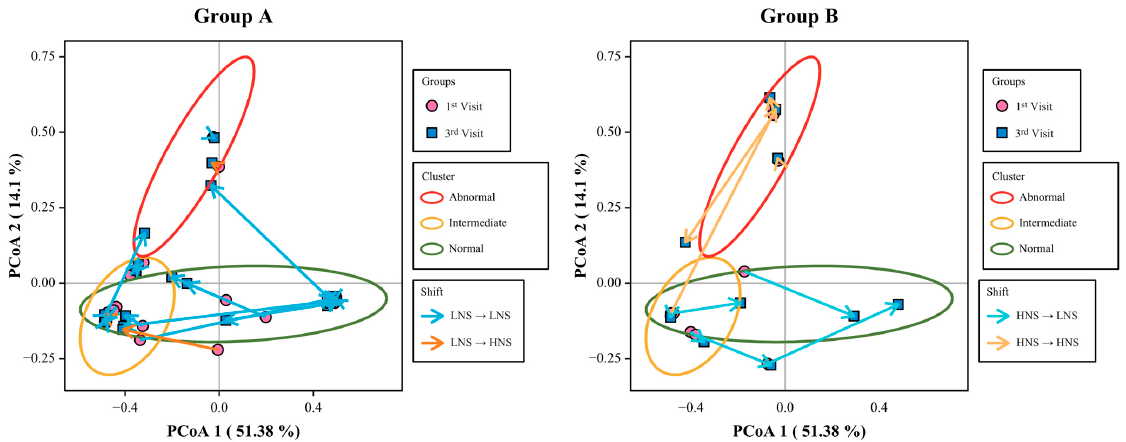
Figure 5. Beta diversity and shift after 6 weeks of LBP intake. The principal coordinate analysis illustrates the beta diversity shift in Group A and B. Arrows represent the shift from the fi rst visit to the third visit. Group A, LNS at fi rst visit; Group B, HNS at fi rst visit. PCoA, principal coordinate analysis.